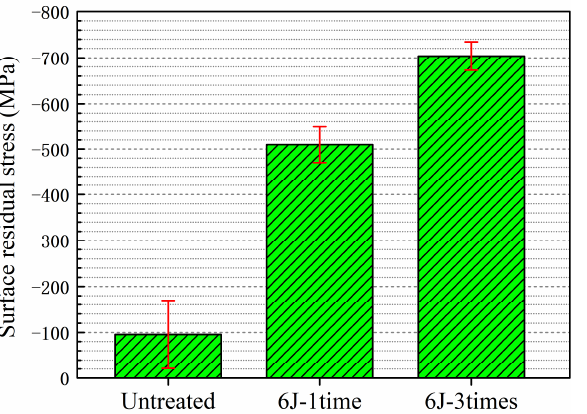
Figure 5. Surface residual stress of Ti-13Nb-13Zr coupon before and after the LSP treatment with 6J- 1time and 6J-3times.